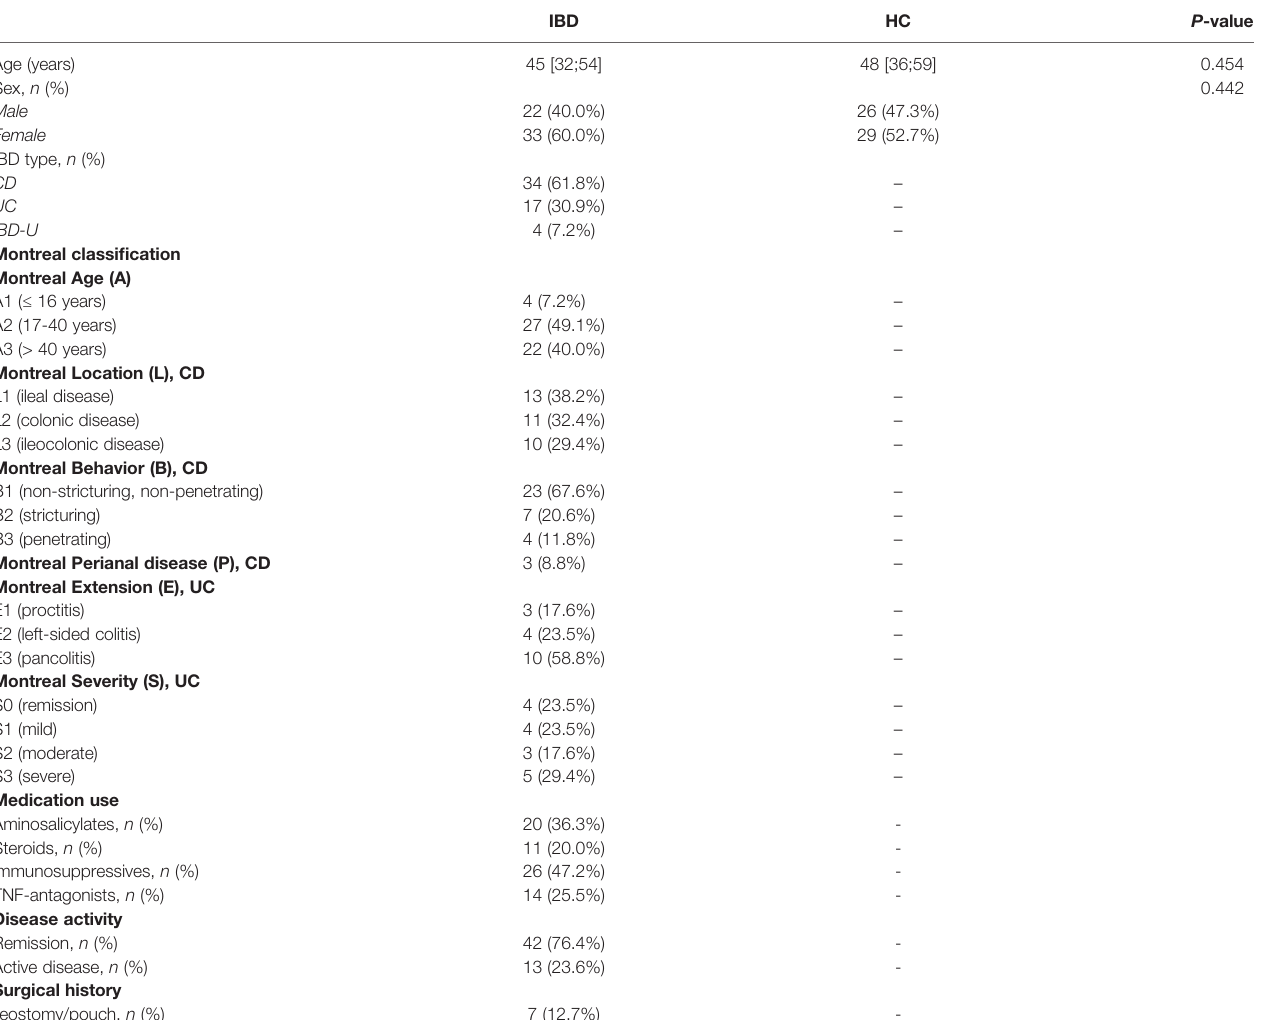
TABLE 1 | Demographic and clinical characteristics of the study